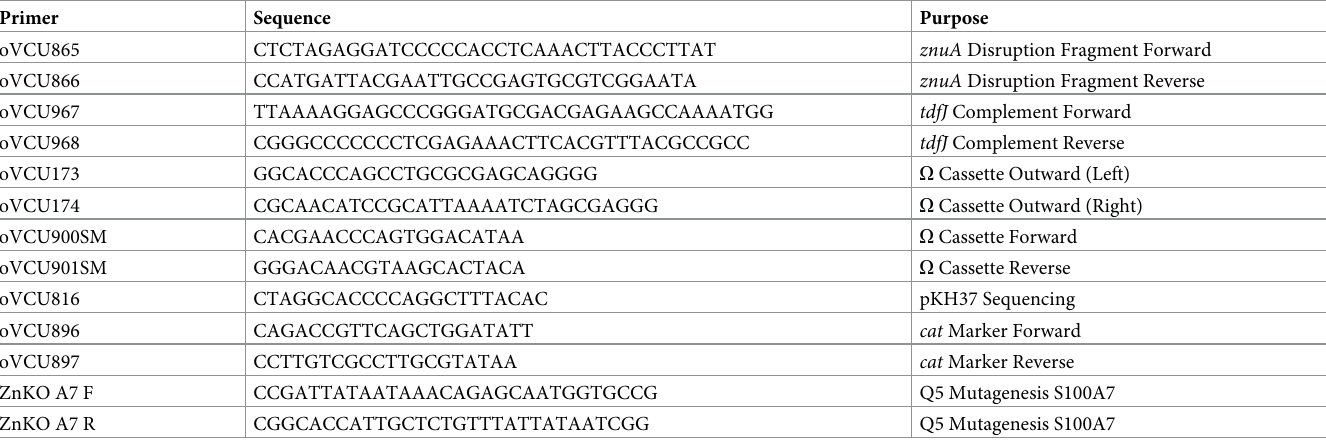
Table 1. Primers used in this